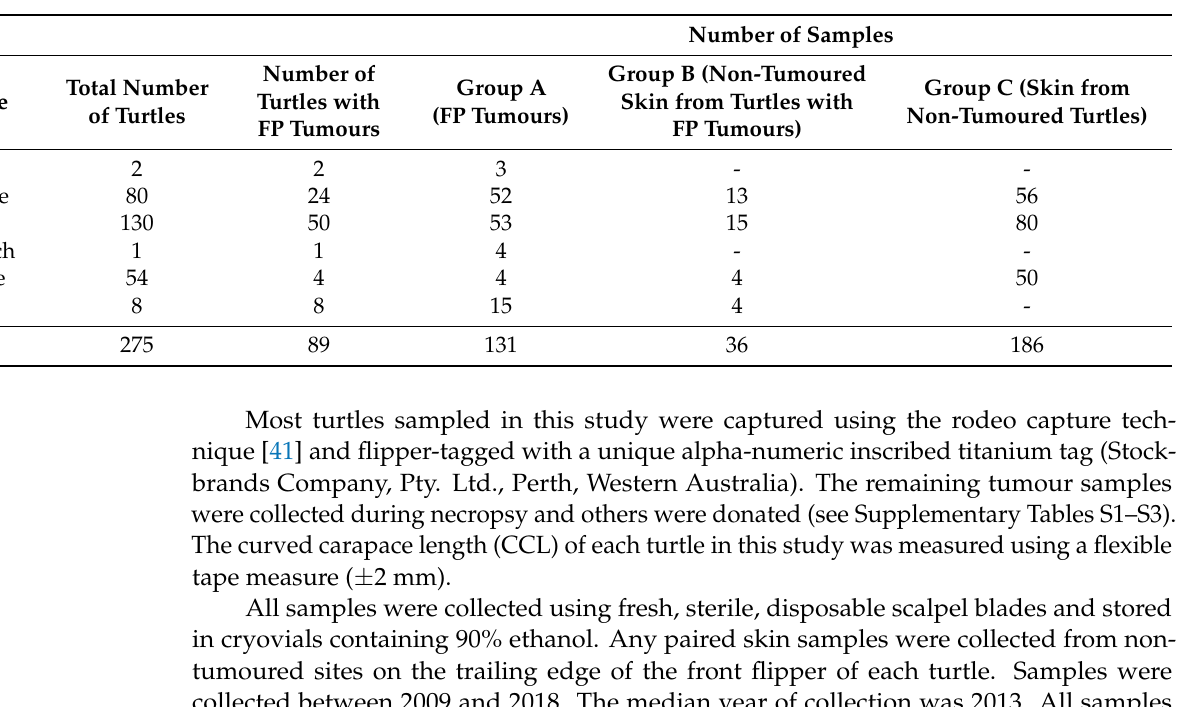
Table 1. The number of turtles used in this study categorised by study site and sample type.